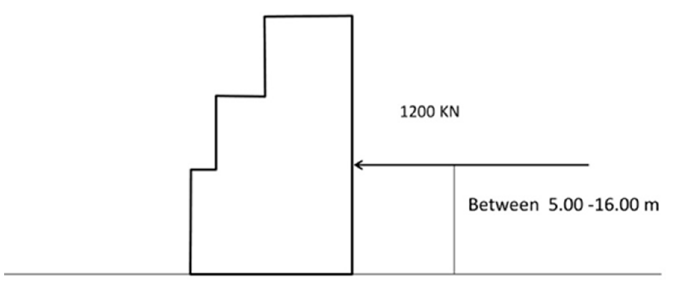
Figure 5. Load state C.